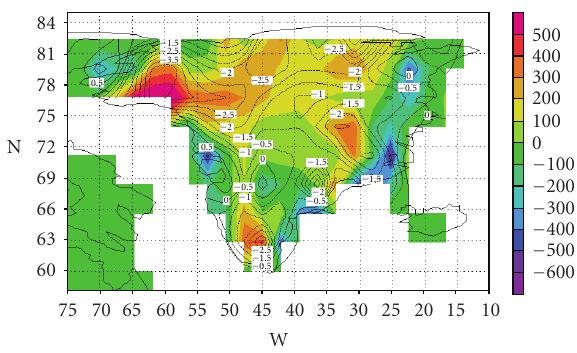
Figure 4: Sensitivity of o ffl ine CLM3.5 simulated Greenland ground temperature (TG) to the surface height (experiment case minus control run, T42 resolution). The 17-year, monthly averaged TG in the experiment case is using ICEsat-observed Greenland surface height. The fields are June, July, and August averages. The color bar is surface height di ff erence (m) and the contour is temperature di ff